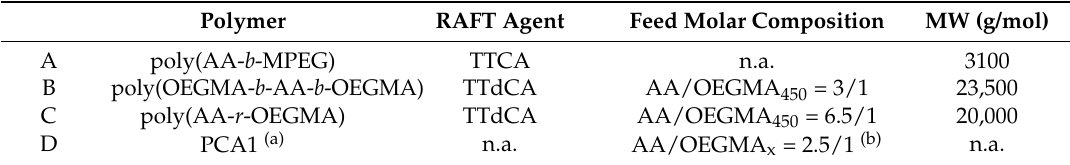
Table 3. Structural features of the copolymers used as colloidal